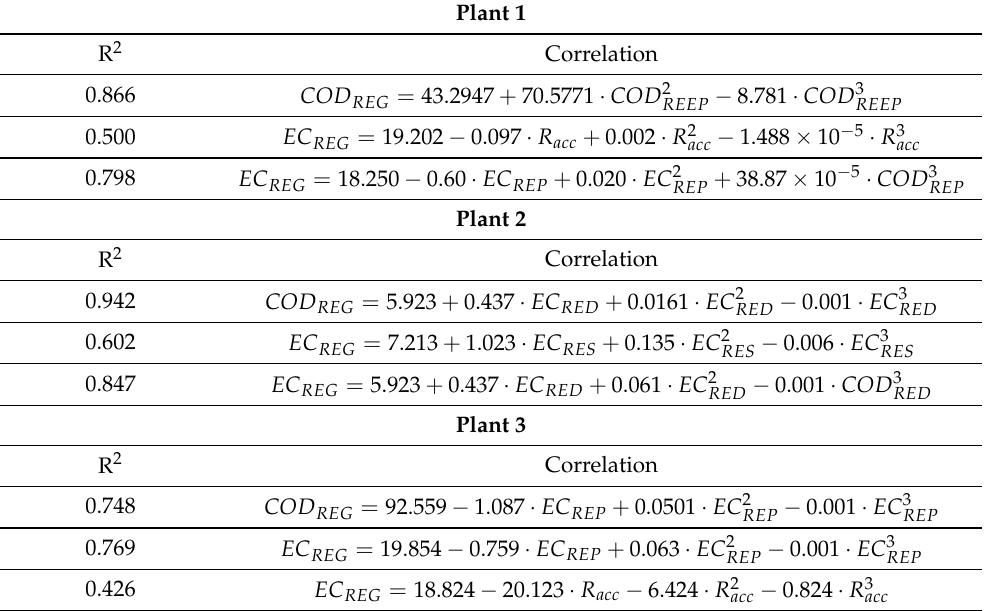
Table 2. Relations between variables of